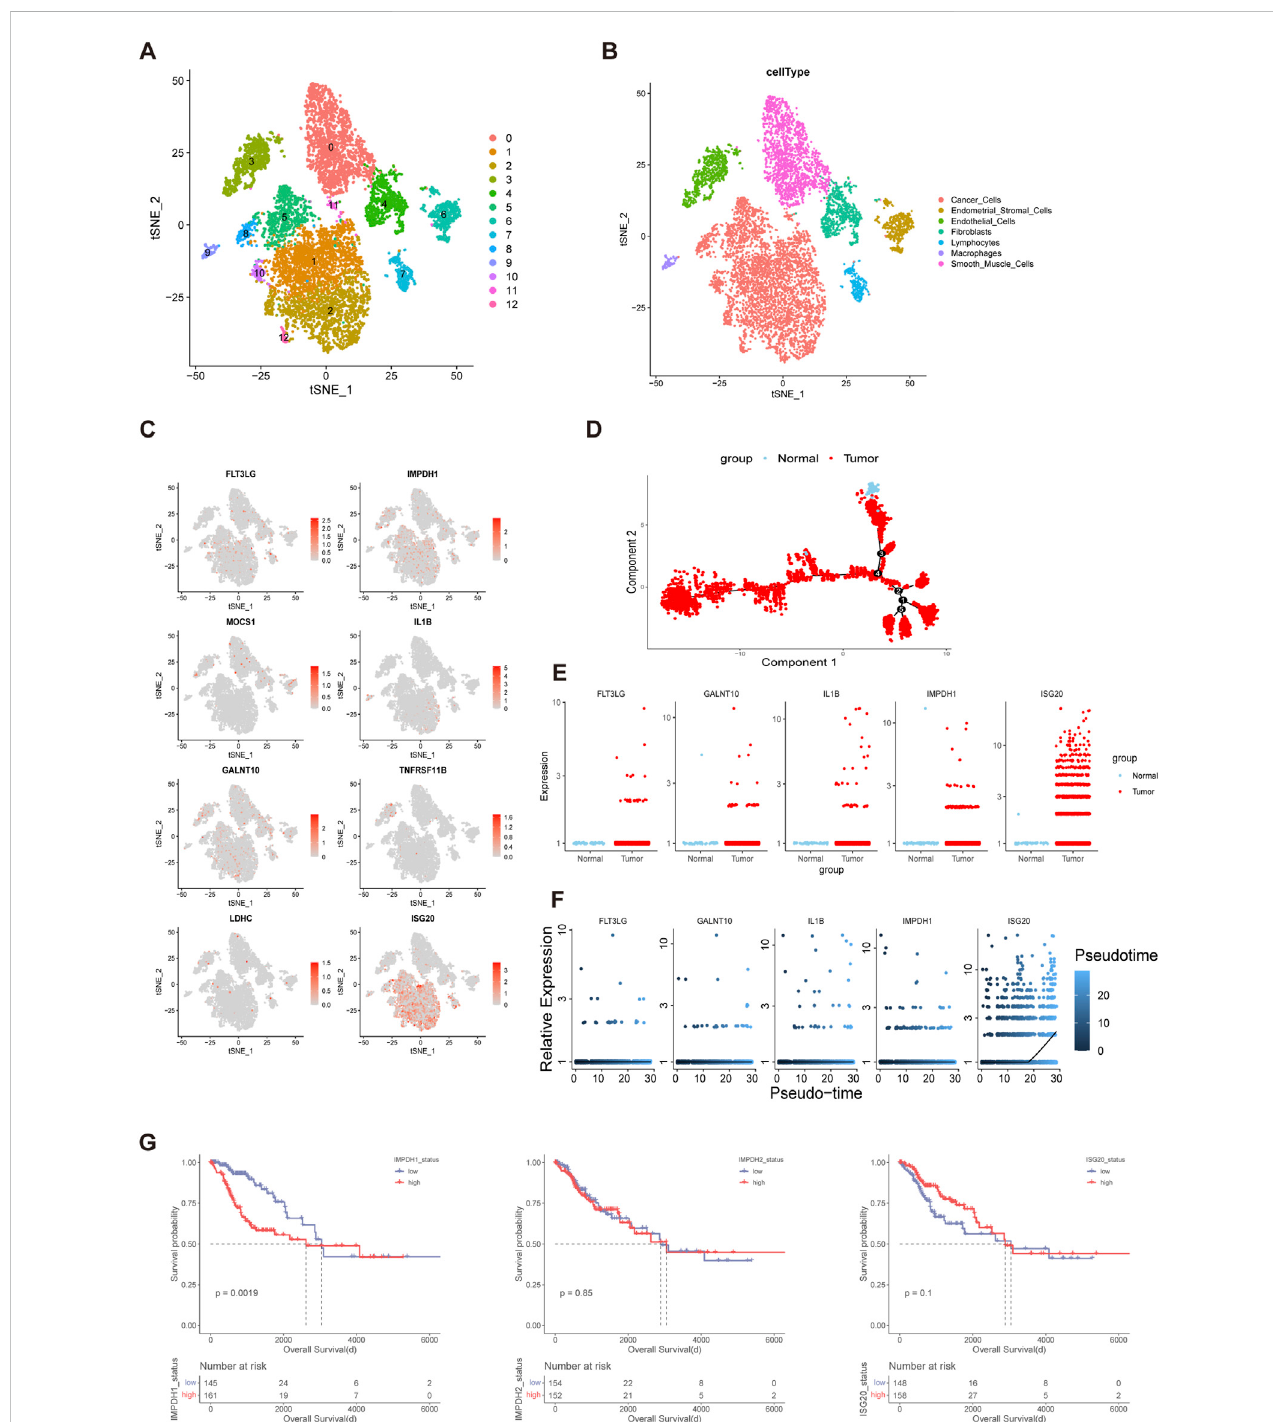
FIGURE 5 IMPDH1wasASigni fi cantPrognosticRiskGeneinCervicalCancer (A,B) Thet-distributedstochasticneighborembedding(t-SNE)plotdemonstratingthe main cell clusters in cervical cancer and identi fi cation of the main cell types. (C) Heatmap shows the expression of genes in the risk models. (D) Development trajectory plot of cervical cancer cells in pseudo-time analysis. (E) Differential expression of the genes involved in the risk model between the normal cervix cells and cervical cancer cells. (F) Pseudo-time analysis showing the expression patterns of the genes in the risk model along the tumor progression. (G) Kaplan-Meier curves of overall survival of the cohorts with low and high expression level of IMPDH1, IMPDH2 and ISG20 in TCGA.